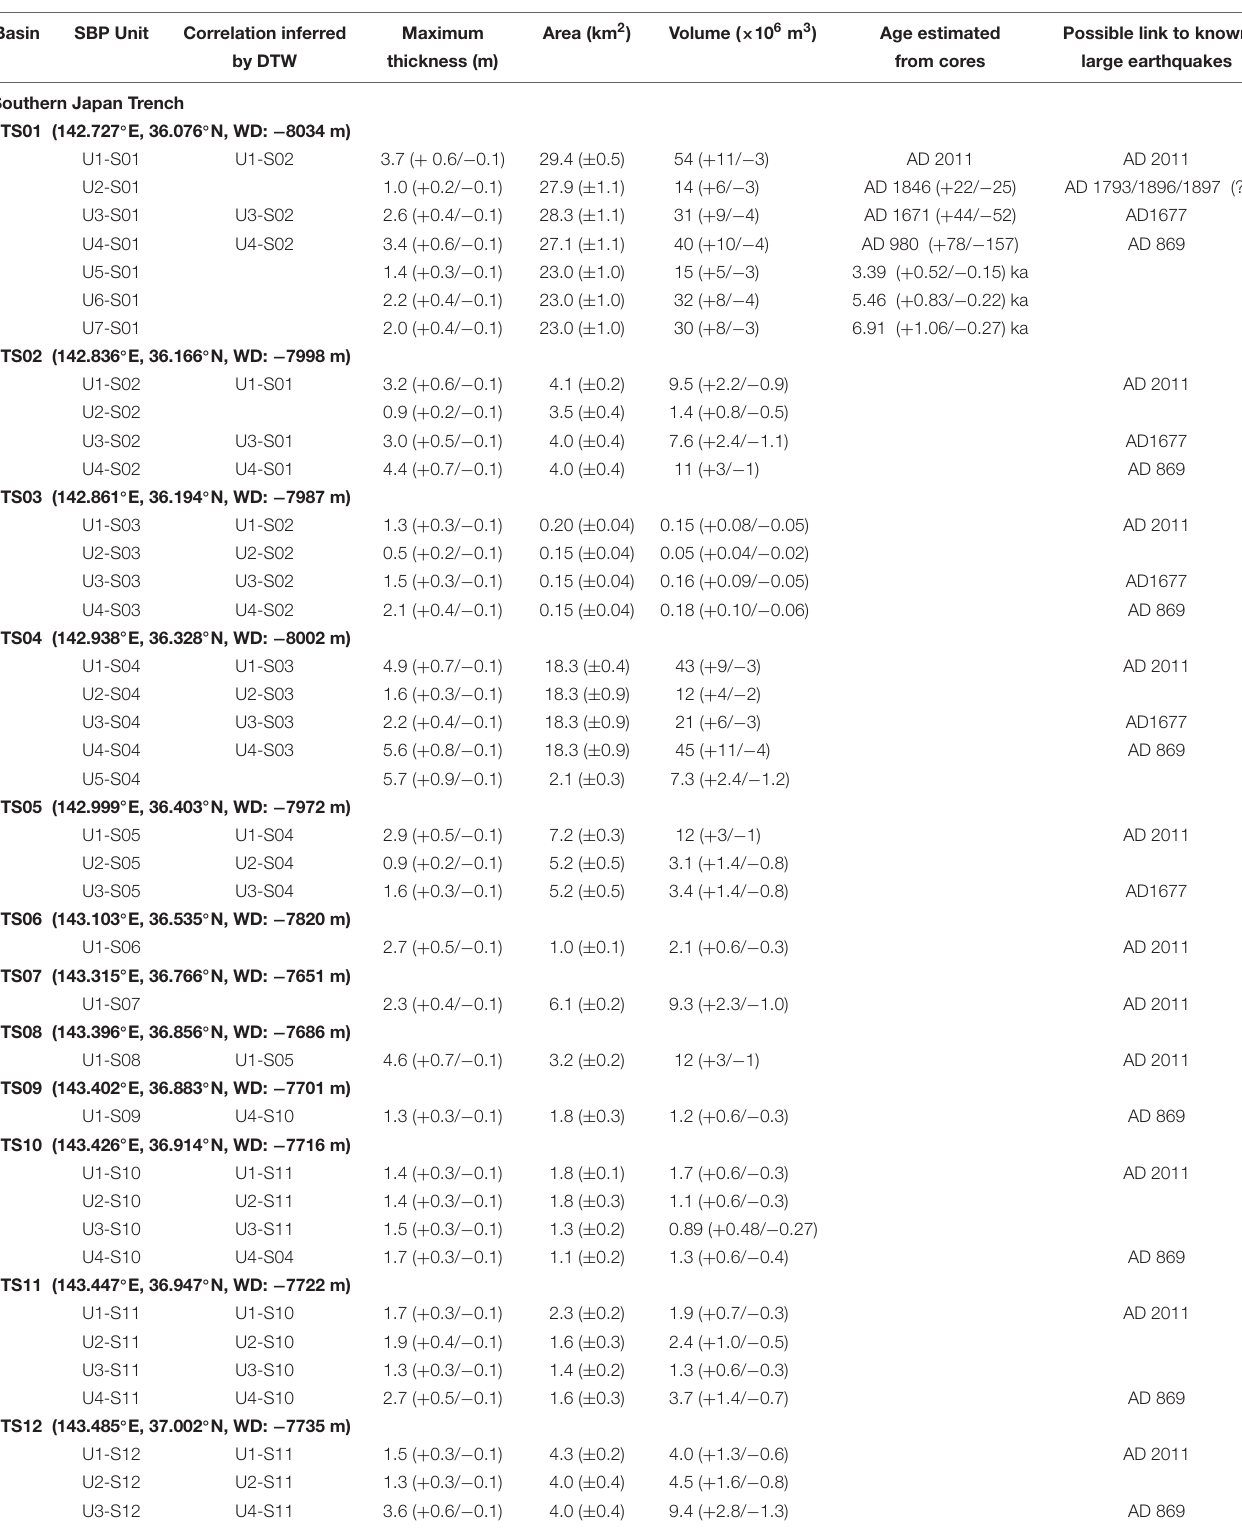
TABLE 1 | Longitude, latitude and water depth (WD) of modern depocenter, acoustically transparent SBP body units, correlation to neighboring SBP units inferred by DTW, maximum thicknesses, areal extents, and volumes of identified event deposits, estimated ages from cores, and possible links to historically known large earthquakes at a given trench fill-basin in the southern Japan